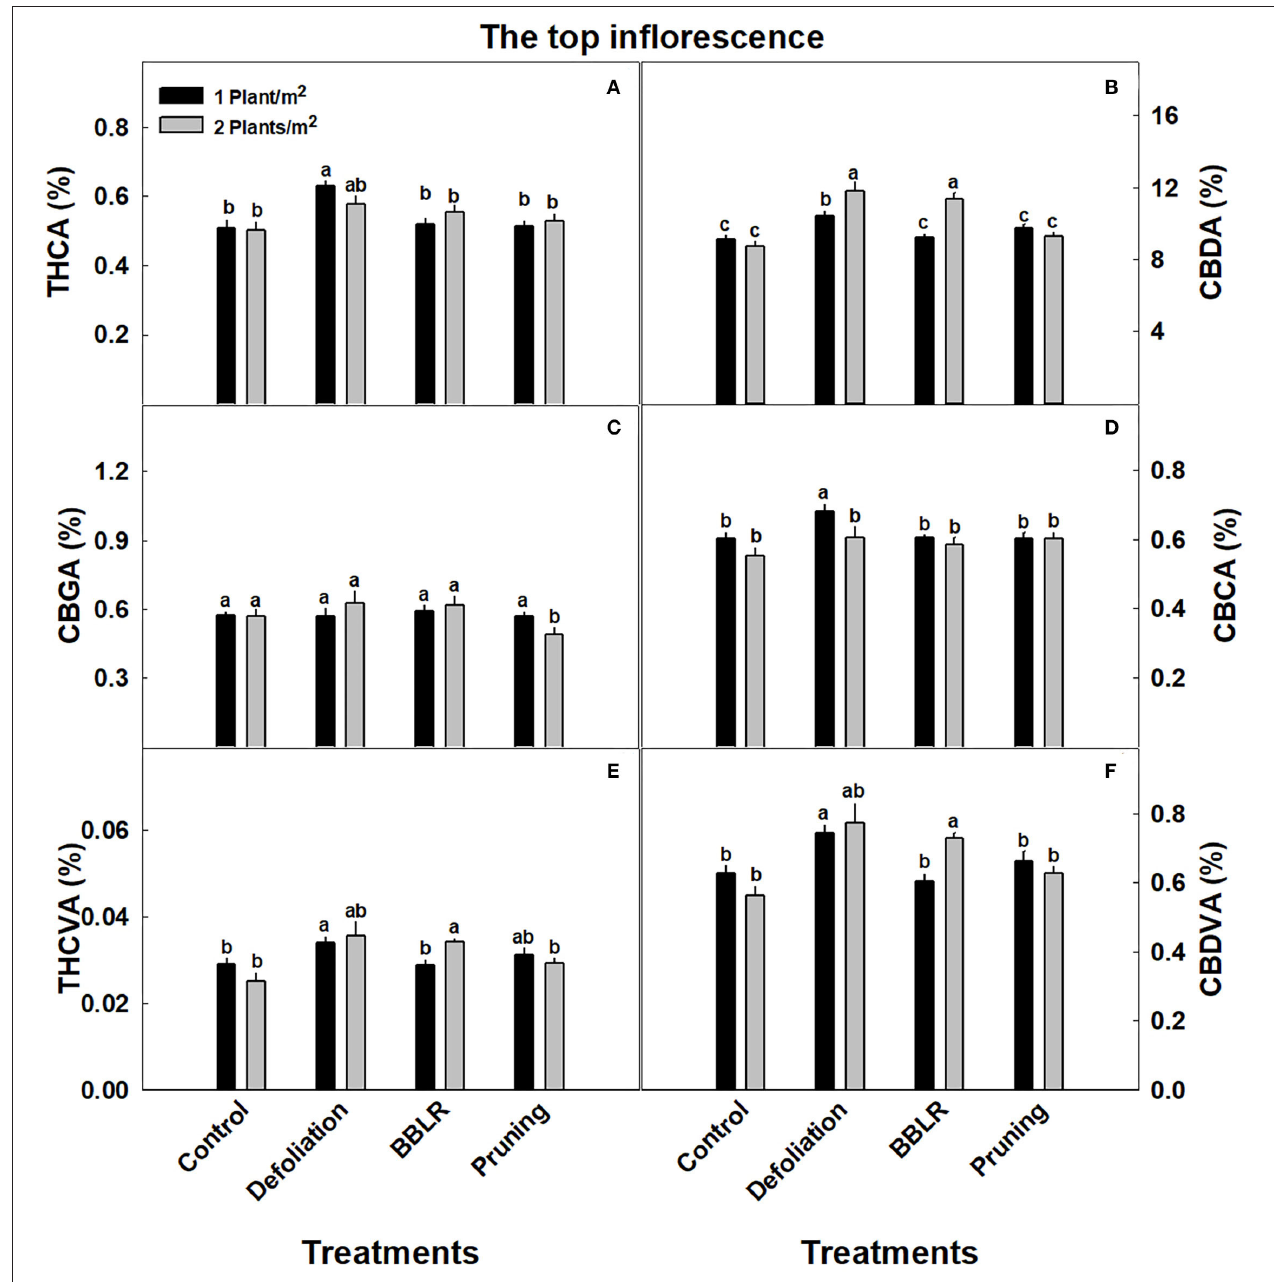
FIGURE 3 | Cannabinoid concentrations at the top inflorescence of cannabis plants grown under two densities and four architectural modulation treatments. The results are means and SE ( n = 6). THCA (A) , CBDA (B) , CBGA (C) , CBCA (D) , THCVA (E) , and CBDVA (F) . Different letters above the bars represent significant differences between treatments by Tukey HSD test at α = 0.05. “BBLB” removal of leaves and branches from the bottom part of the